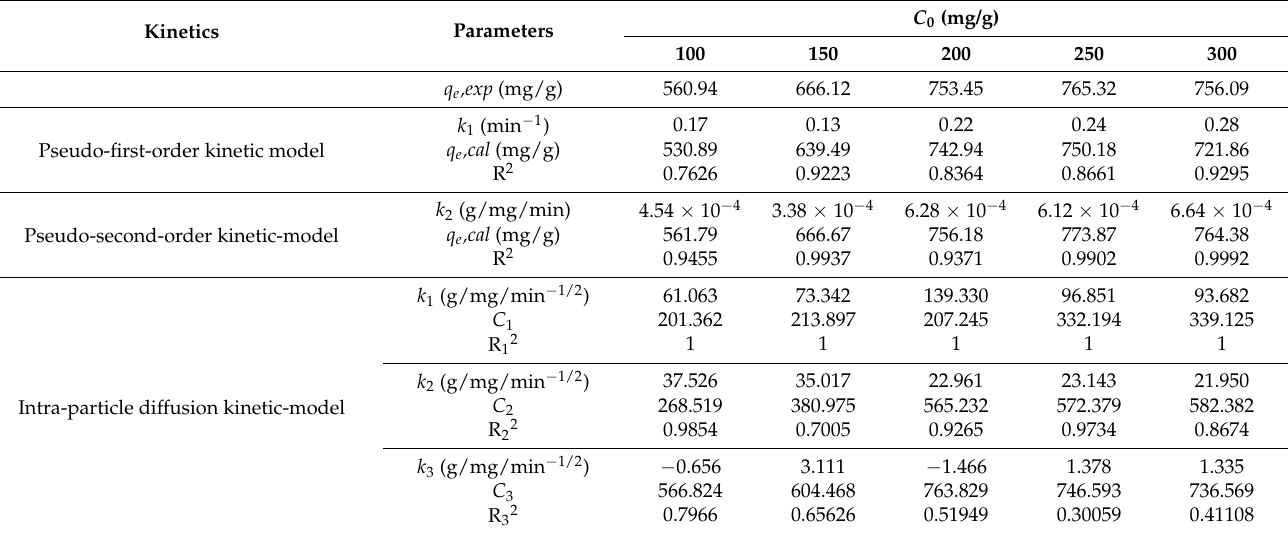
Figure 9. Plots of ( a ) pseudo-first-order, ( b ) pseudo-second-order, and ( c ) particle diffusion models of the BAC for MB. Table 3. Kinetics parameters for adsorption of the